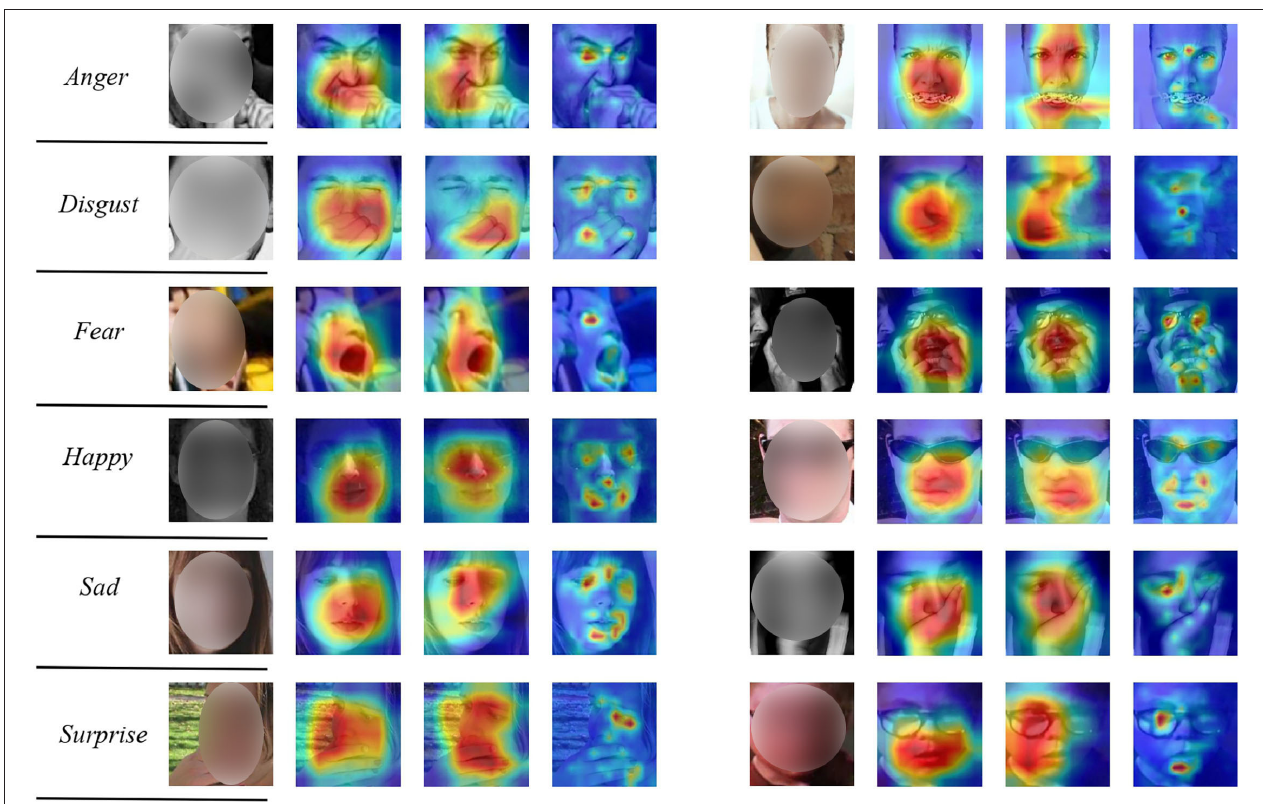
FIGURE 5 | Attention maps of several facial images with occlusions. For each input face image, the first, second, and third column, respectively, show the attention map of TFE ( w/o D, w/o T ), TFE ( w/ D, w/o T ), and TFE. Our proposed TFE is capable of perceiving the important facial regions for robust FER. A deep red denotes low attention. A deep red means high attention. Better viewed in color and zoom